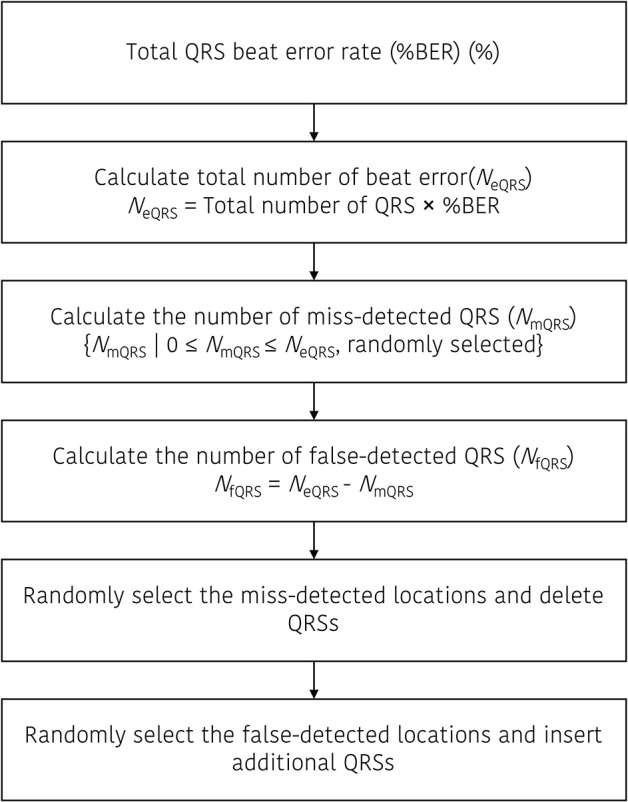
Procedure to update the QRS dataset that includes the beat errors.